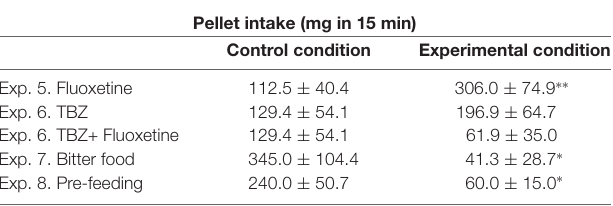
TABLE 1 | Effect of tetrabenazine (TBZ) and fluoxetine alone or in combination, and food manipulations on pellets intake.